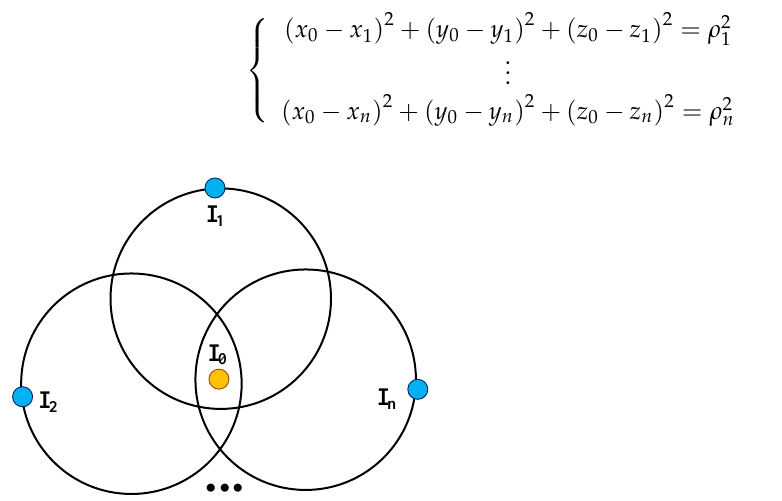
Figure 7. Multilateral